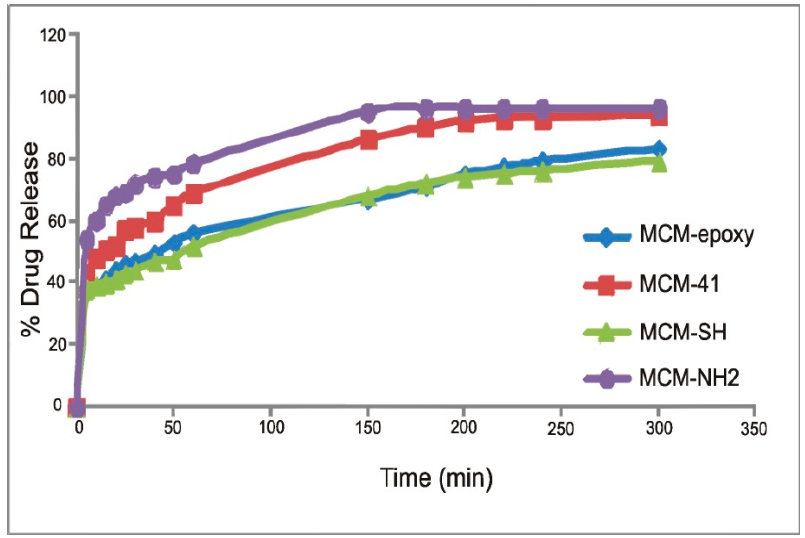
Figure 3. Mean cumulative release of MT (wt. %) from silica carriers during the 5 h of the experiment. Based on the Korsmeyer-Peppas model [28], the release exponent, n, for the all drug-loaded carriers was between 0.40 and 0.53. These values are close to 0.5 and indicate a diffusion-controlled